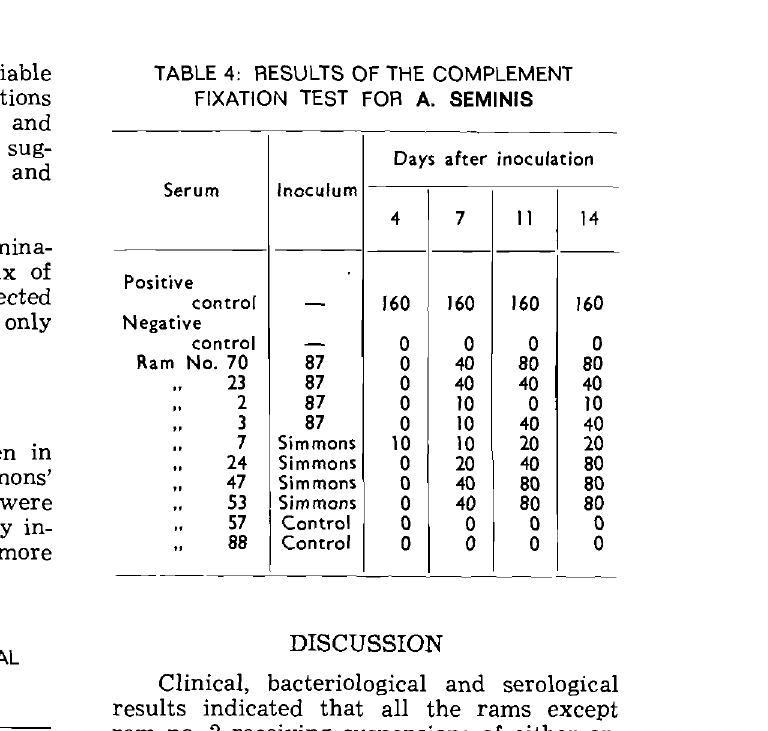
TABLE 3: RESULTS OF BACTERIOLOGICAL